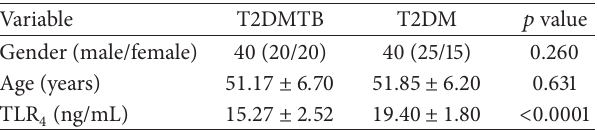
Table 2: Serum TLR 4 levels of patients with T2DMTB and